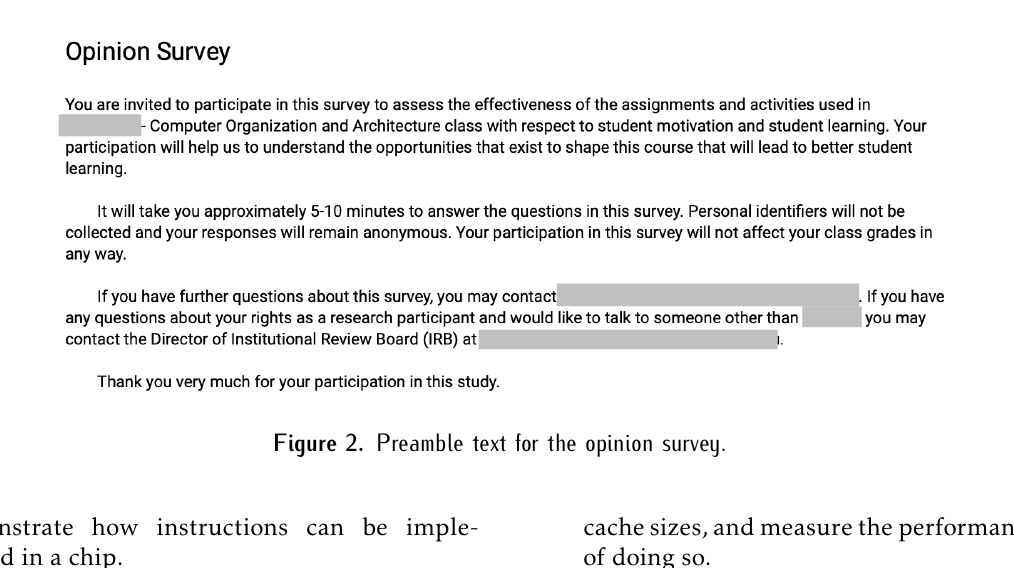
Figure 1. Weekly meeting schedule of the theoretical and hands-on parts of the course.